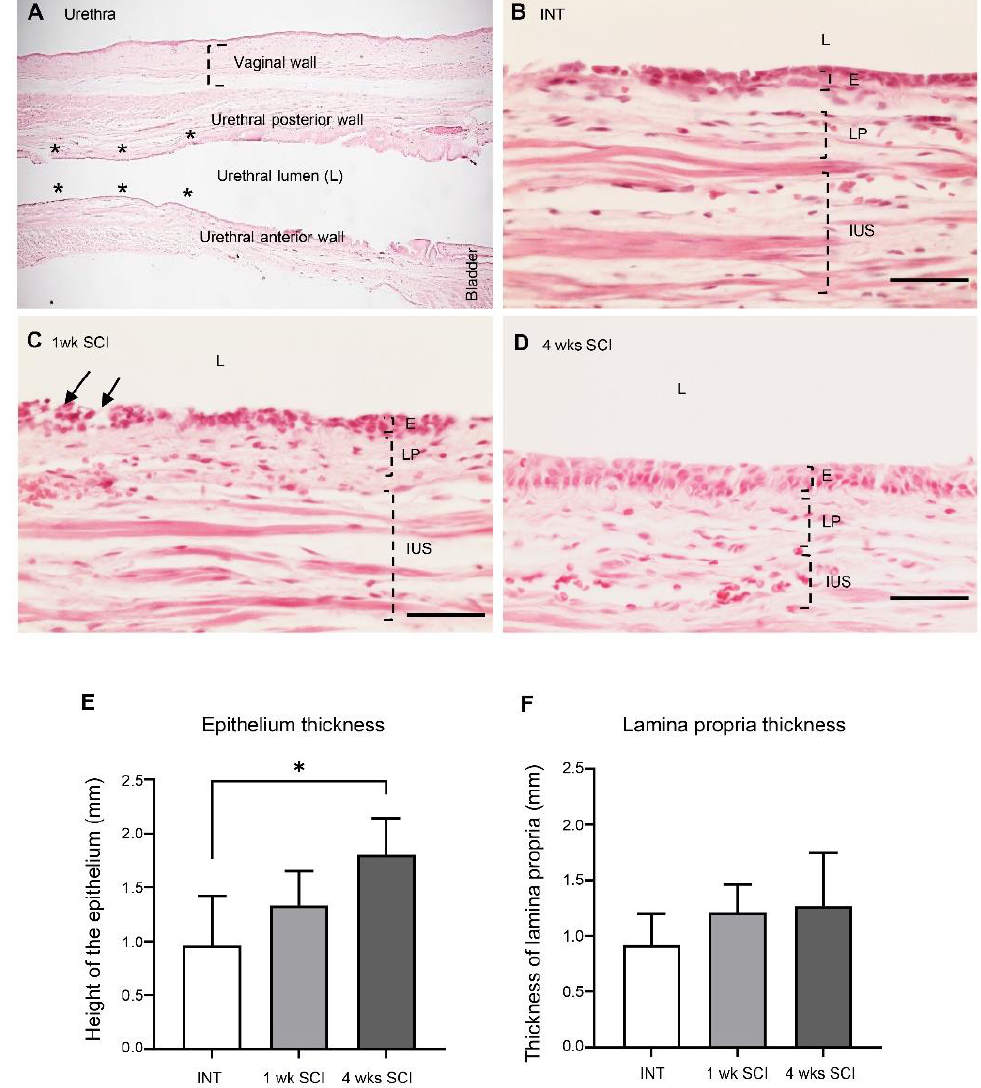
Figure 2. Epithelium and lamina propria organization. The morphology of the urethral wall was studied using hematoxylin and eosin-stained urethral sections. A general view of the urethra is represented in ( A ). The localizations of the vaginal and the urethral wall (posterior and anterior), the urethral lumen, and the bladder are identified. The six locals chosen for measures are marked as